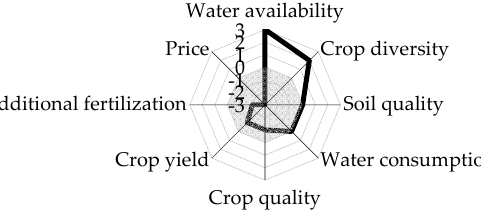
Figure 3. Ranking of factors related to desalinated water use.